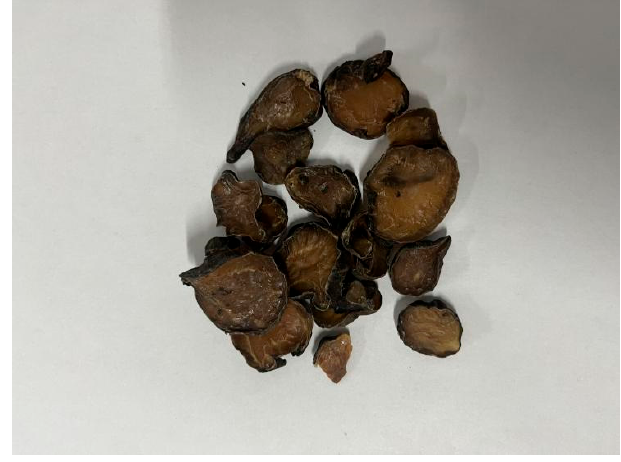
Figure 1. Fu Zi specimens (processed lateral root of Aconitum carmichaelii Debx).